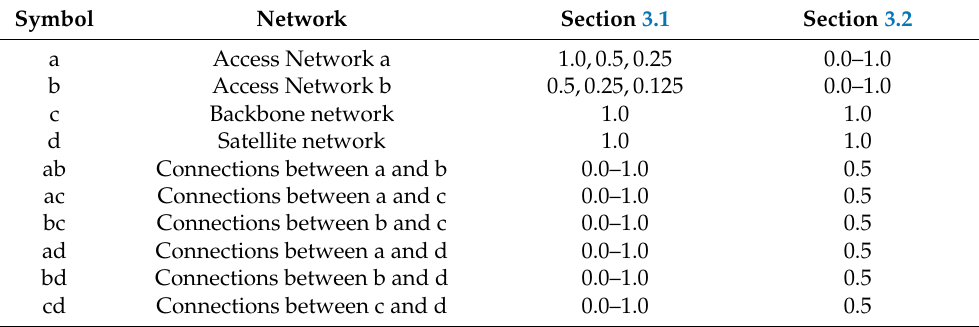
Table 1. Symbols refer to the four networks in Figure 2. The detailed network structure is depicted in Figure 1. The last two columns show the probabilities of sufficient resilience between neighbouring nodes within the networks (the first four rows) and between the networks (the last six rows) used in Sections 3.1 and 3.2,